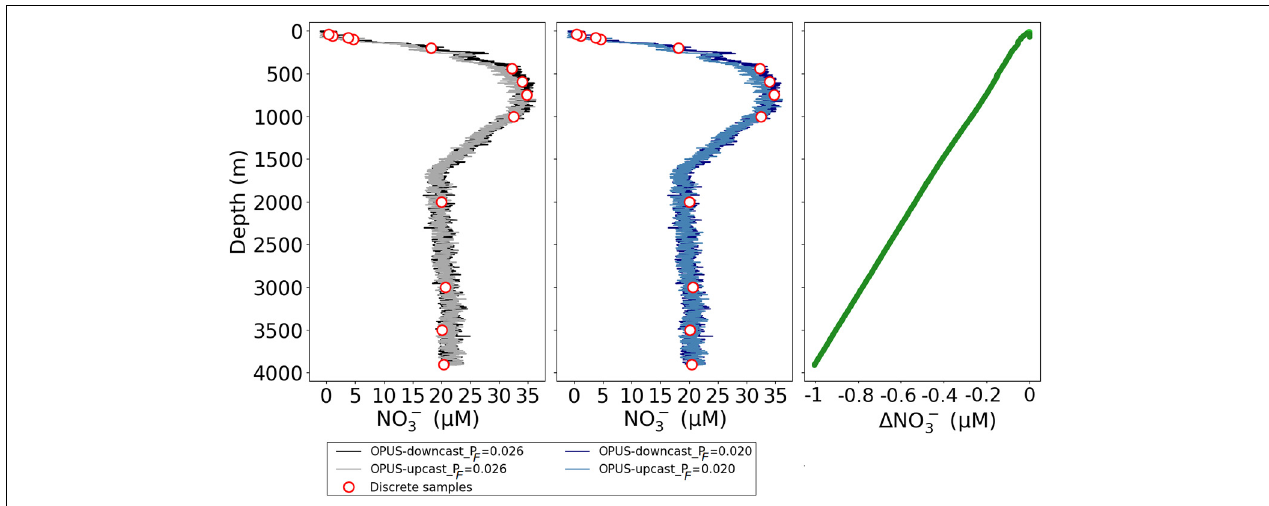
FIGURE 16 | Vertical profiles of NO 3 − concentrations ( µ M) for cruise M158 and cast CTD71, in which the sensor data were processed using both P F = 0.026 (left panel, black and gray lines) and P F = 0.020 (middle panel, dark and light blue lines). The offset between them is presented in the right panel; (cid:49) NO 3 − refers to the sensor NO 3 − data obtained with P F 0.020-obtained with 0.026. Red circles are for the discrete water samples analyzed in the laboratory (see also Figure 14 ).